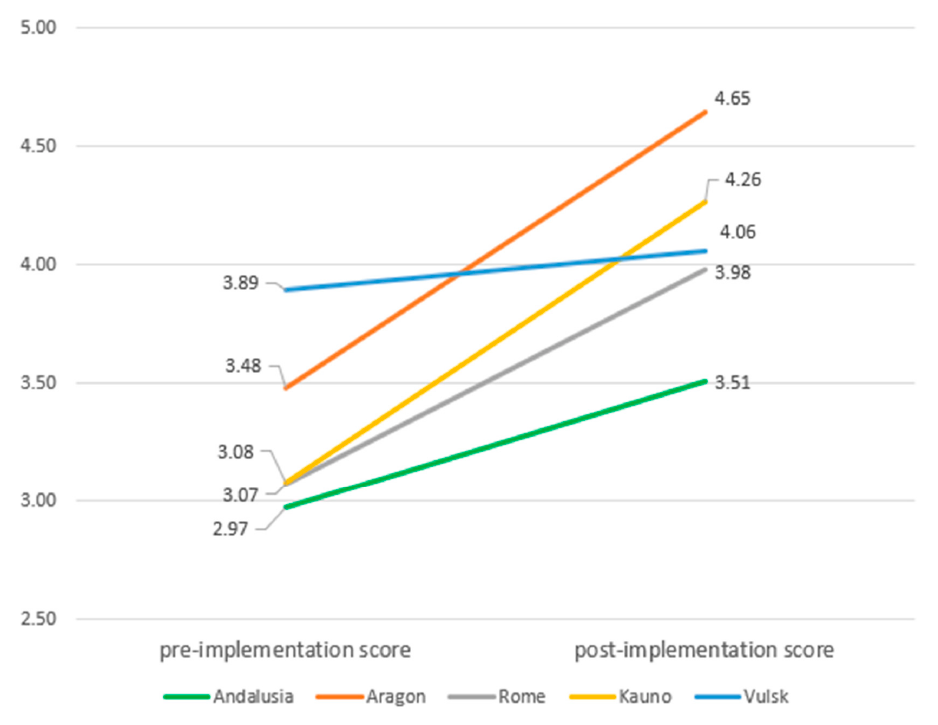
Figure 2. Estimated marginal means of PACIC+ 5As summary score by site and by pre- and post-implementation.